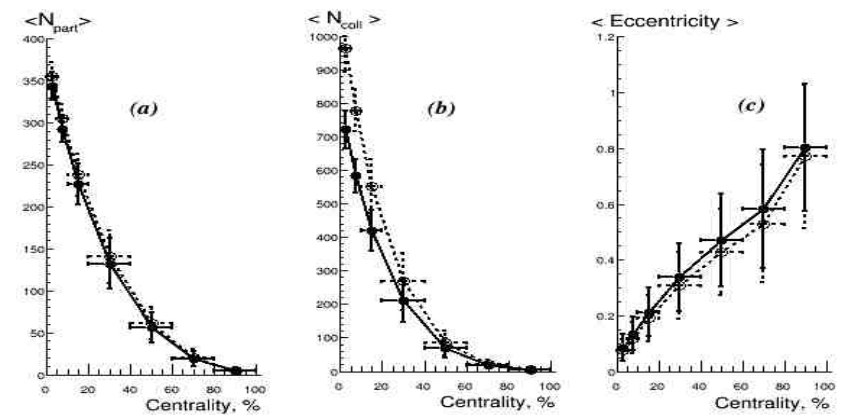
Figure 1. Mean multiplicities of the participating nucleons, binary collisions and the eccentricity as functions of the centrality (figures a, b and c, respectively). Dispersions of the quantities are presented as error